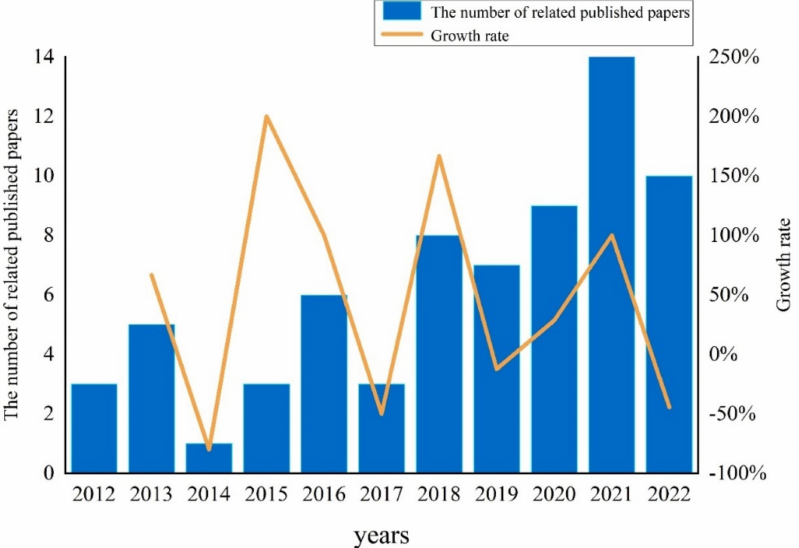
Figure 2. Statistics of published papers of disassembly sequence